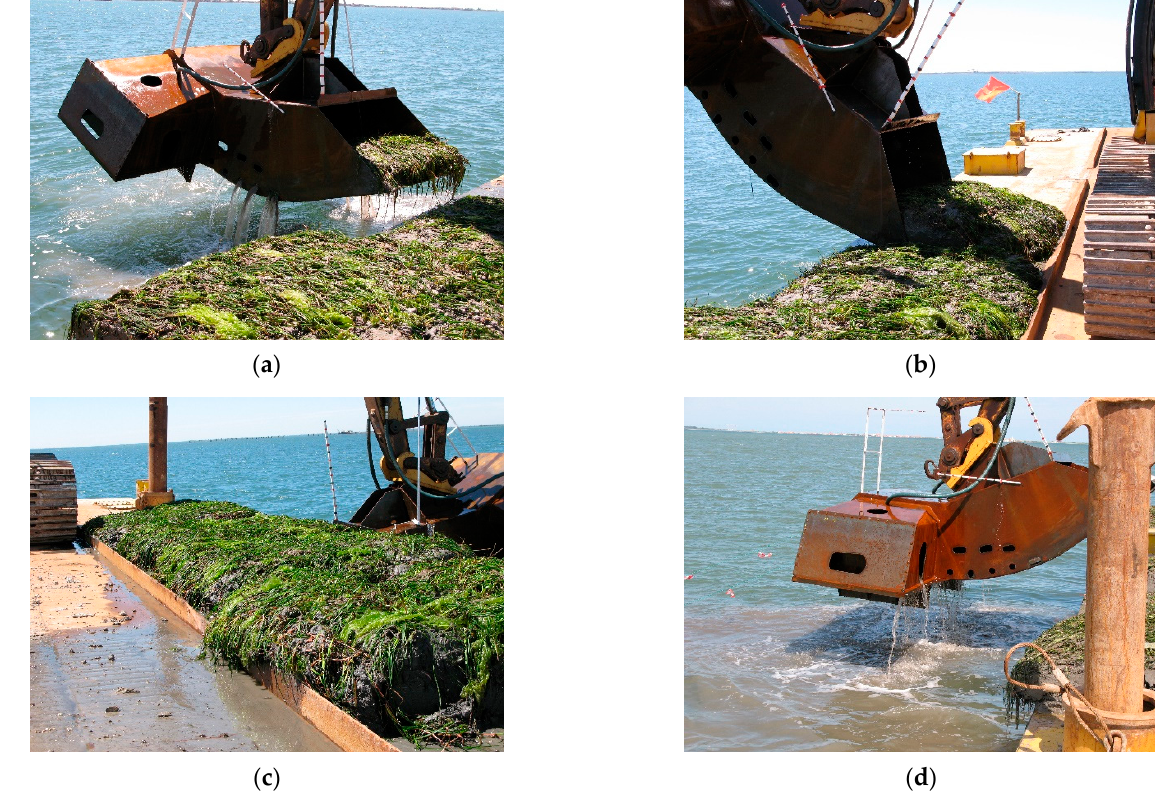
Figure 6. Mechanized transplantation procedure: ( a , b ) harvesting of sods from the donor site, ( c ) temporary storage of sods on the pontoon and ( d ) deposition of the sods in the transplantation site.